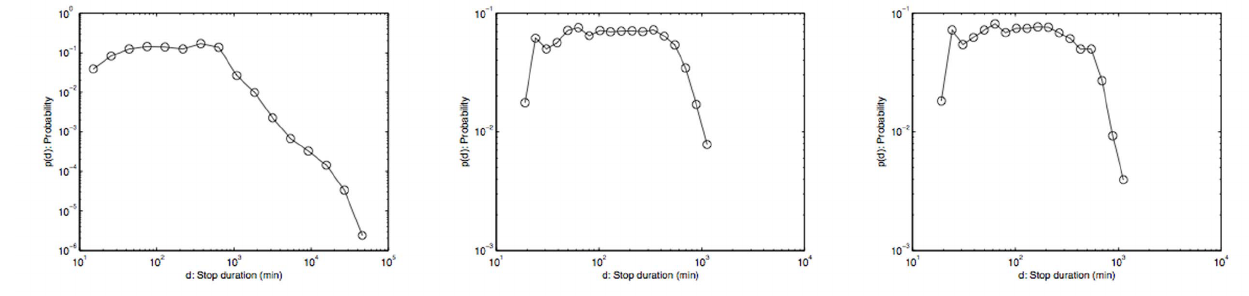
Figure 8. Probability mass function of stop duration of subjects.